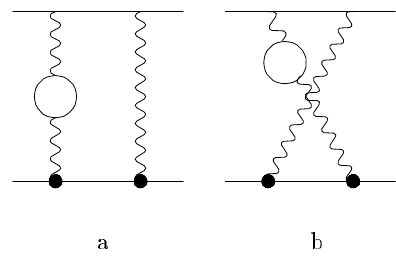
Figure 4. Nuclear structure and vacuum polarization correction